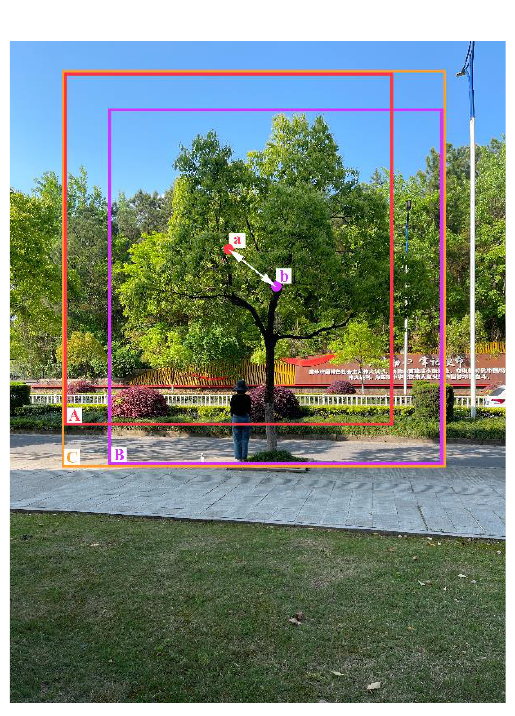
Figure 5. Schematic diagram of CIoU_Loss calculation.